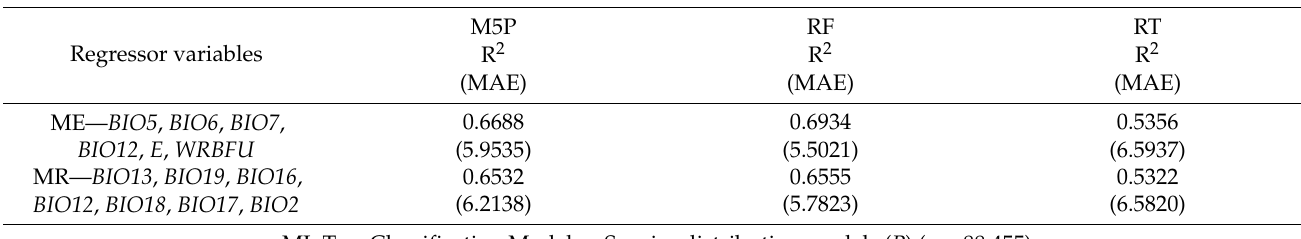
Table 3. Species distribution and productivity of ML models. Performance statistics (after the 10-fold cross-validation approach) for the best ML regression and classification trees algorithms essayed: M5P or J48, respectively; random forests (RF); and random tree